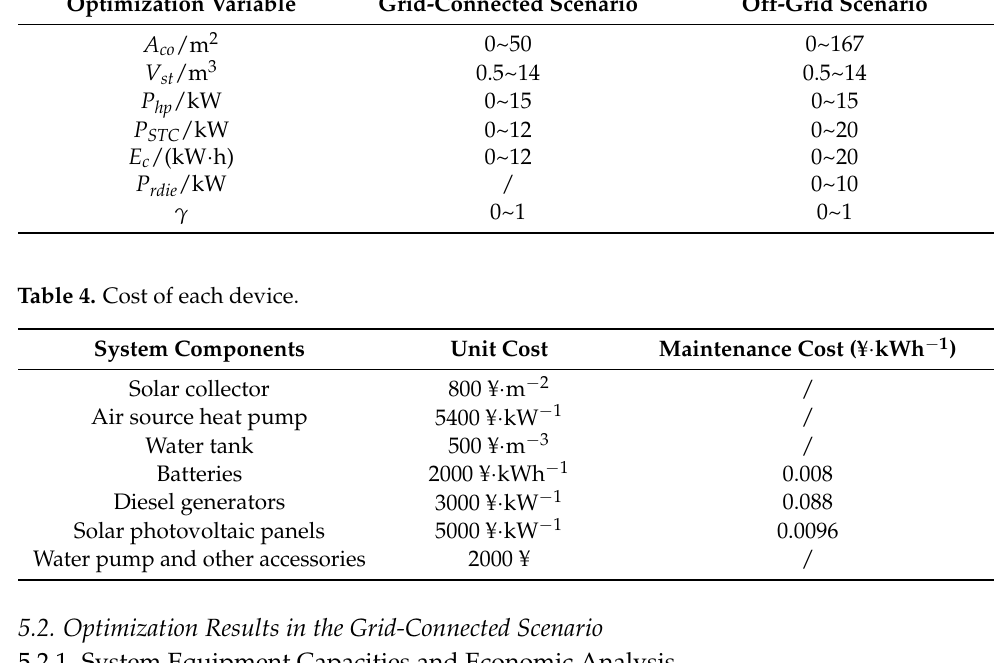
Figure 6. Electricity and heating demands during typical weeks.